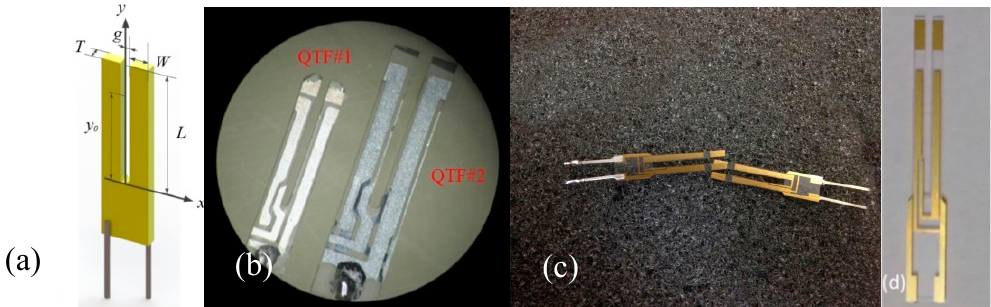
Figure 1. ( a ) Sketch and coordinate system of a quartz tuning fork (QTF). The origin of the y -axis is at the junction of the QTF; ( b ) picture of the commercial QTF#1 and #2; ( c ) picture of two samples of the custom QTF#3. ( d ) and a picture of the custom QTF#4.